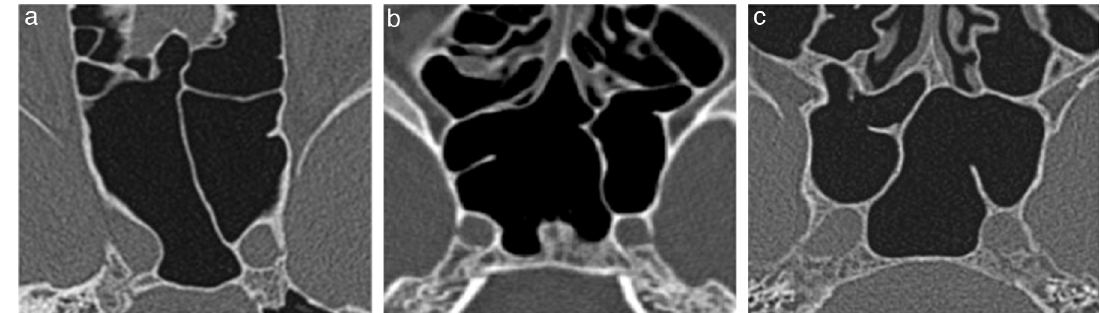
Septation type definition and its relationship with the internal carotid artery protuberance (ICAp). Axial reformatted images obtained from CT data scanning. (a) Intersphenoid septation in the left ICAp. (b) Intersphenoid septation in the left ICAp and an accessory septation in the left sinus wall. (c) Intersphenoid septation in the right ICAp and an accessory septation in the left